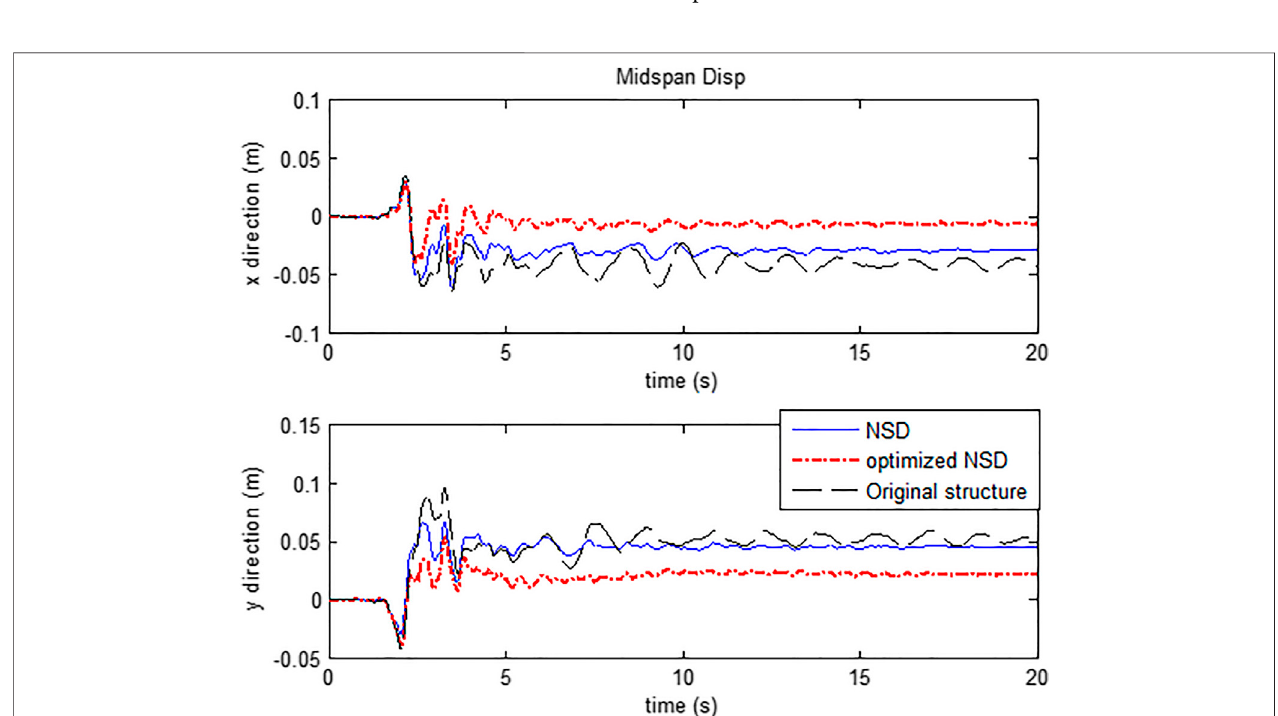
FIGURE 6 | Time history of displacement responses at mid-span under NPalmspr